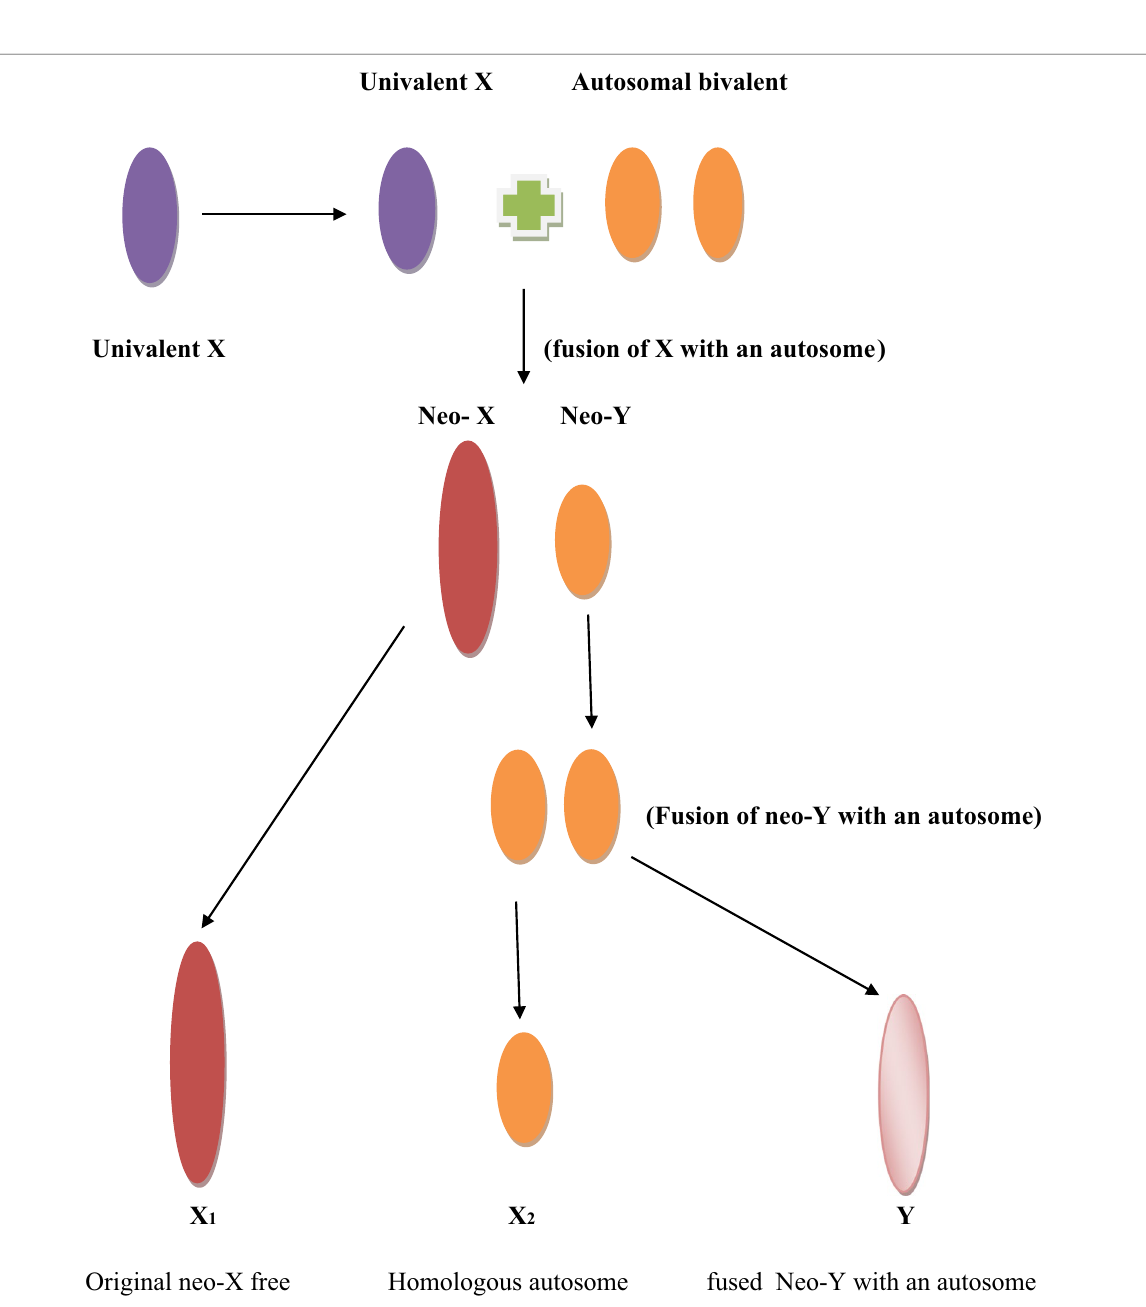
sequences while it is epigentically controlled (Guerra et al., 2010).